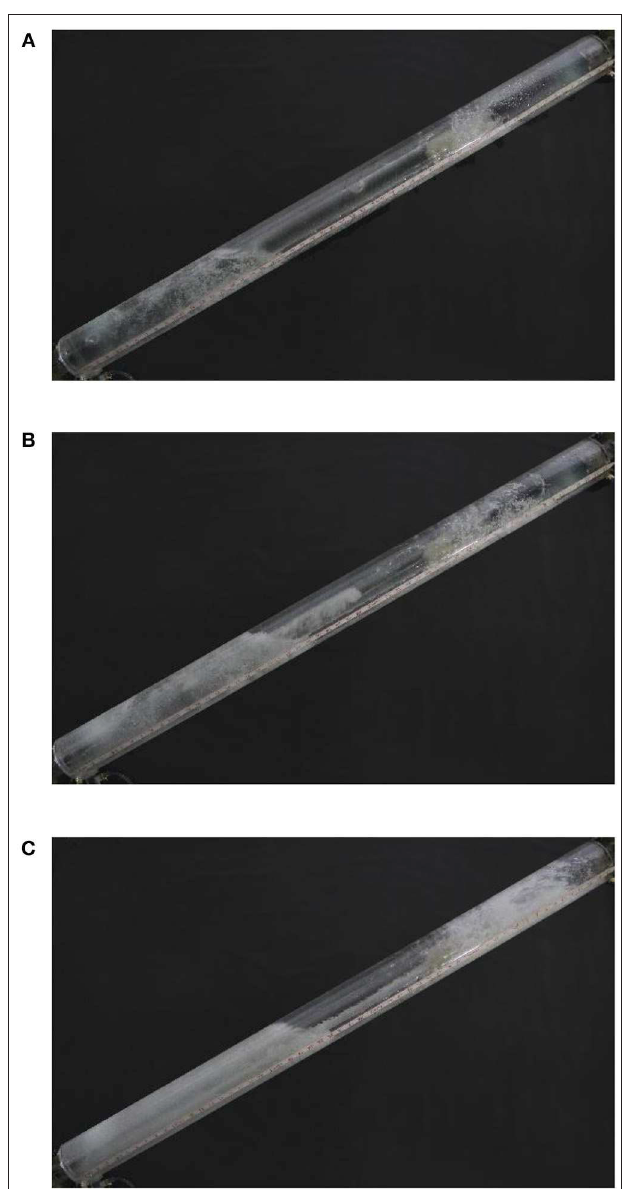
FIGURE 5 | The performance of the separator under different flows. (A) Dispersed bubble flow (Vl = 3.33 m 3 /h, β = 5%). (B) Intermittent flow (Vl = 3.33 m 3 /h, β = 50%). (C) Intermittent flow (Vl = 3.33 m 3 /h, β = 90%).